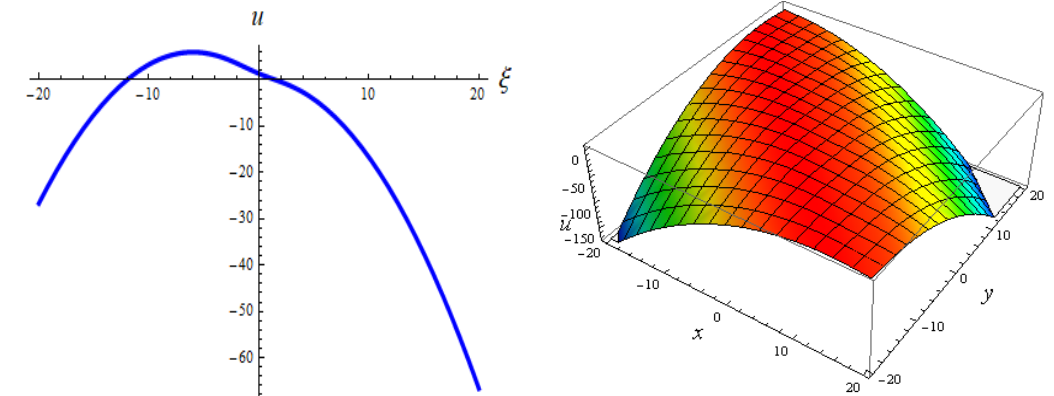
Figure 3: (a) 2D plot for u 4 . (b) 3D plot for u 4 ( x , y ) , when t = 0 .